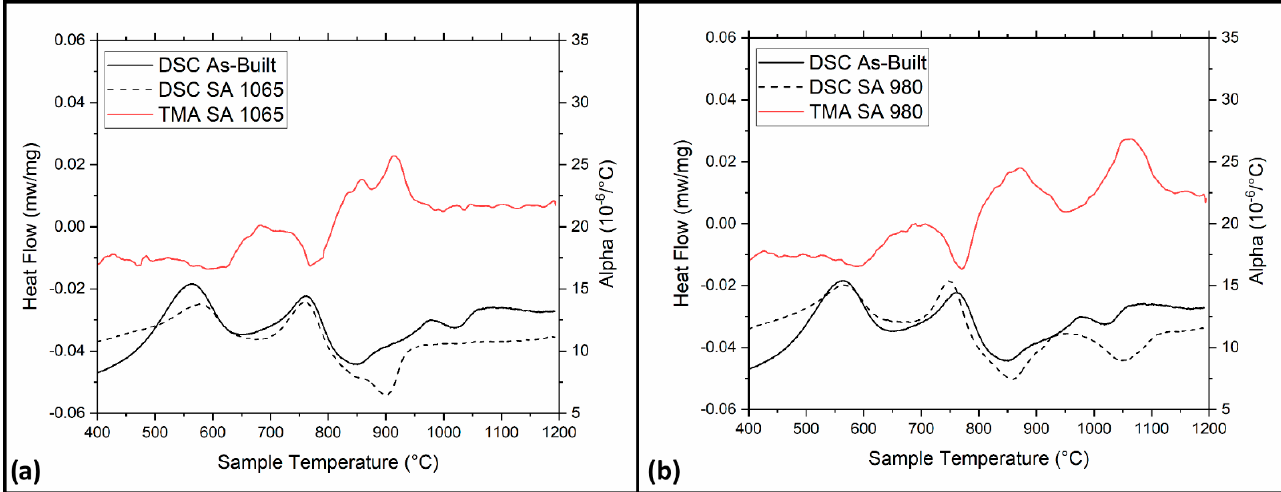
Figure 3. DSC and TMA of IN718 after solution annealing at 1065 °C ( a ) and 980 °C ( b ); solid and dashed lines refer to DSC and TMA, respectively.